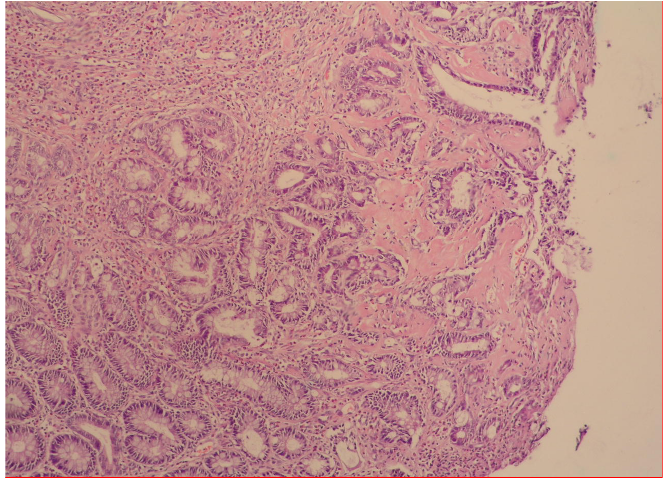
FIGURE 2 – Photomicrograph of a well-differentiated adenocarcinoma. Hematoxylin-eosin (40x) FIGURE 3 – Photomicrograph of a well differentiated adenocarcinoma. Fine brown-stained cytoplasmic pigmentation. Positive for COX-2 (two-stage polymer technique, 40x)